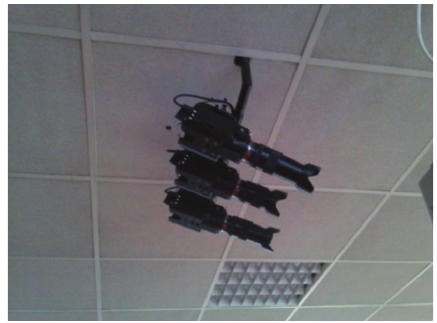
Figure 11: Three cameras Sony BPE